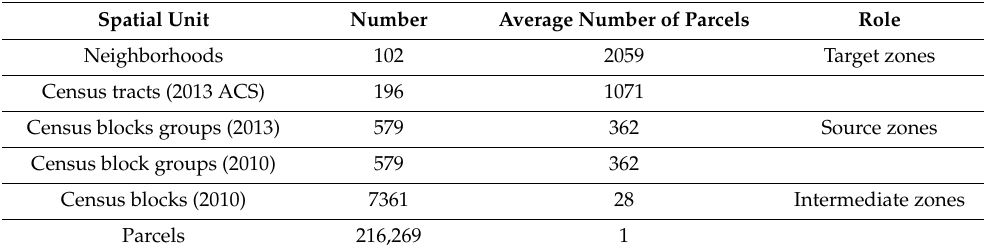
Table 1. Spatial units in San Francisco and their roles in areal